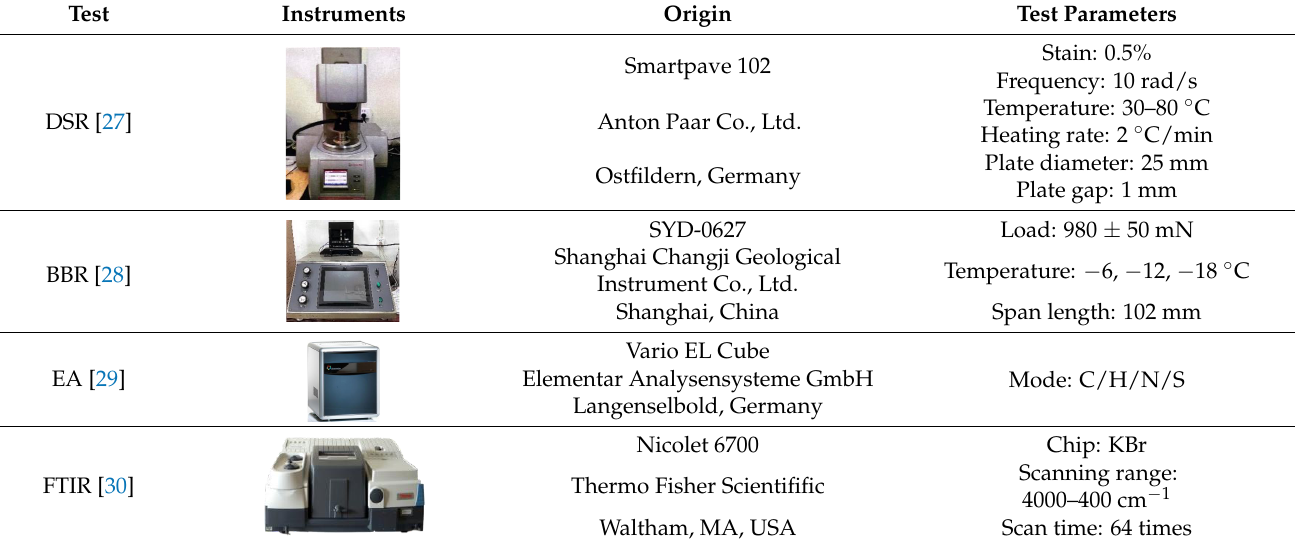
Table 2. Relevant information of instruments.